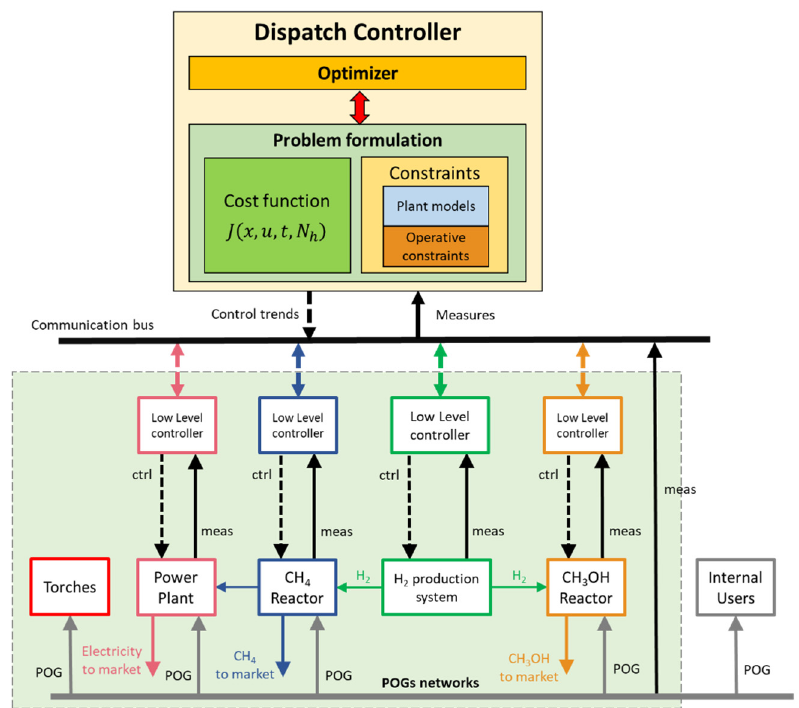
Figure 6. Conceptual coupling between DC and POG-based methane and methanol production units.